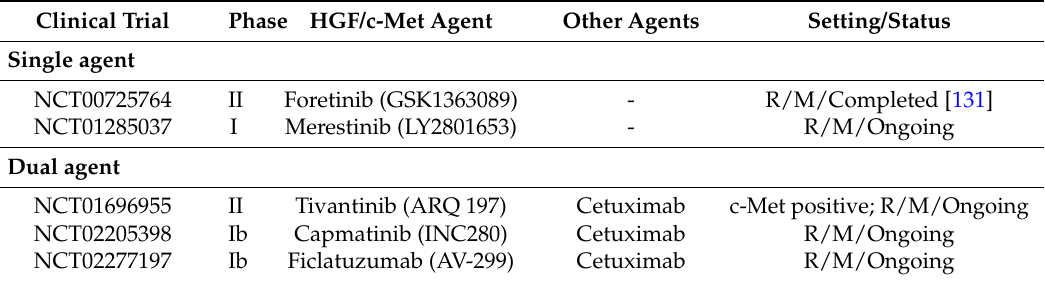
Table 4. Clinical Trials assessing HGF/c-Met Targeted Therapies in R/M HNSCC. Clinical Trial Phase HGF/c-Met